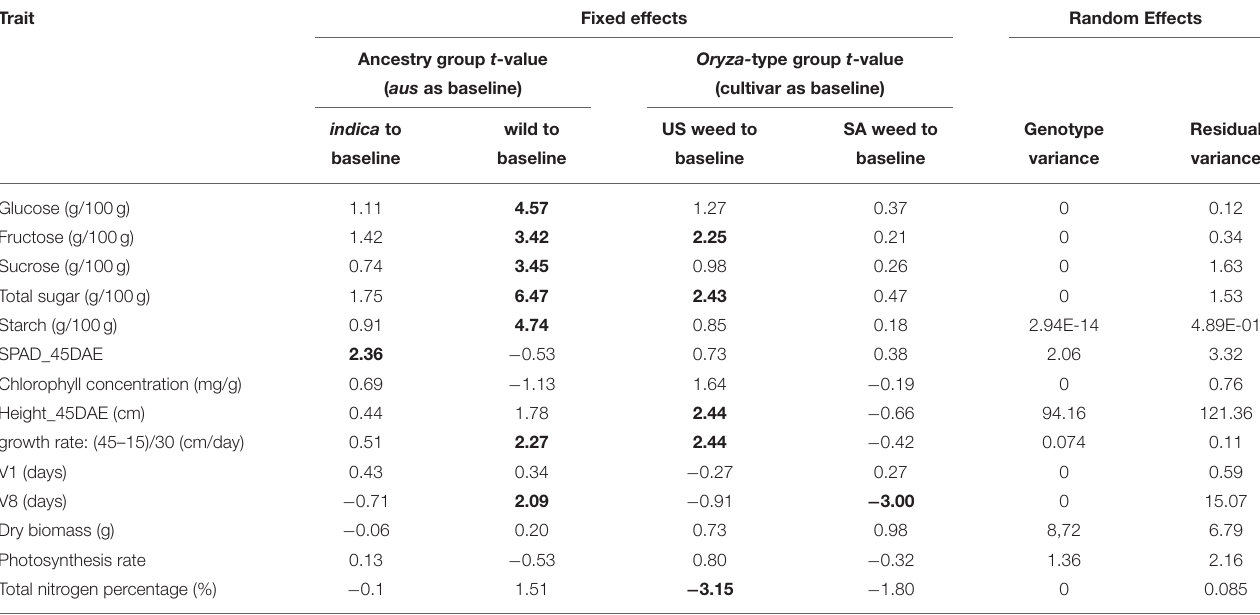
TABLE 2 | Linear mixed model analysis for genotypes from different ancestry and Oryza groups.